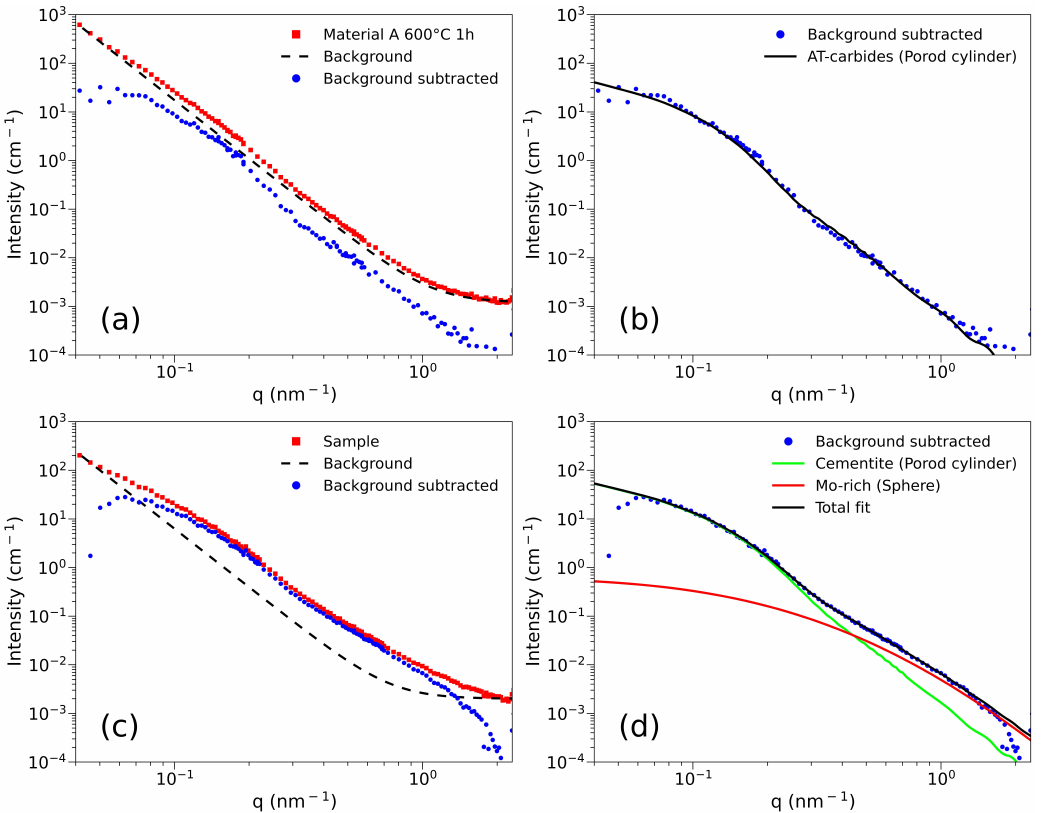
Figure 2. Signals without Porod background and particle fitting. The fitting procedure of Material A, AsQ is given in ( a , b ), and Material A 600 ◦ C 1 h is given in ( c , d ). Table 2. Input parameters for model-dependent